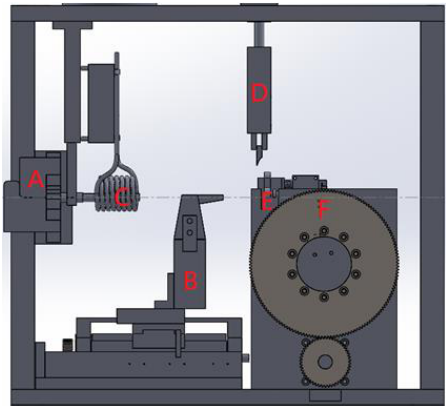
Figure 6. Depiction of proposed mechanical system.